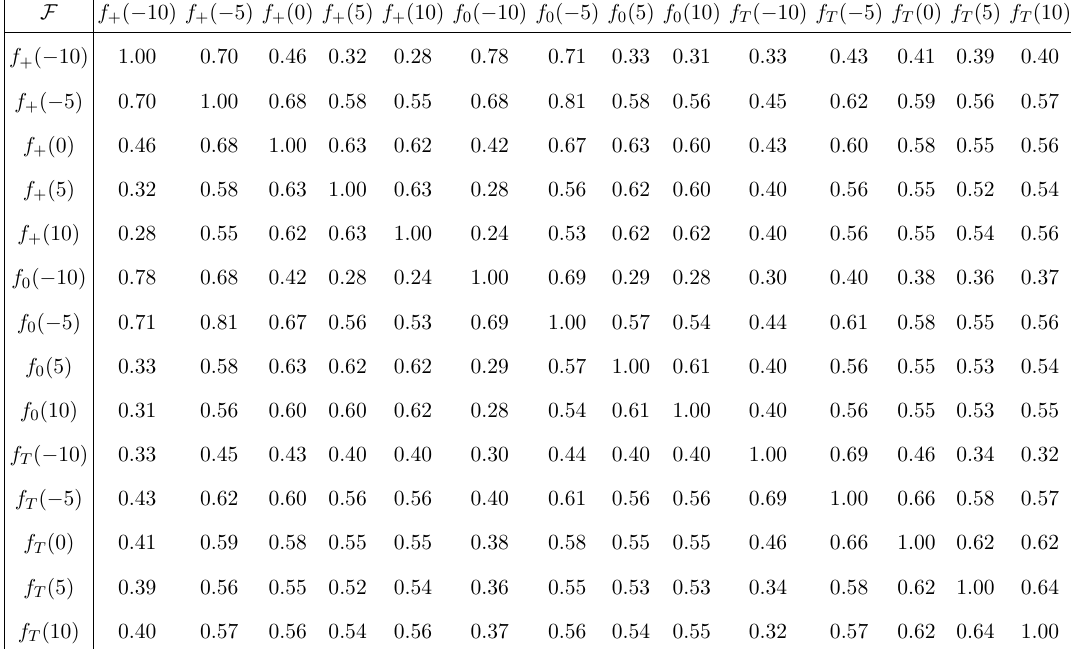
Table 10 . The correlation matrix between the LCSR form factors pseudo data points. The momentum transfer is given as the argument in units of GeV 2